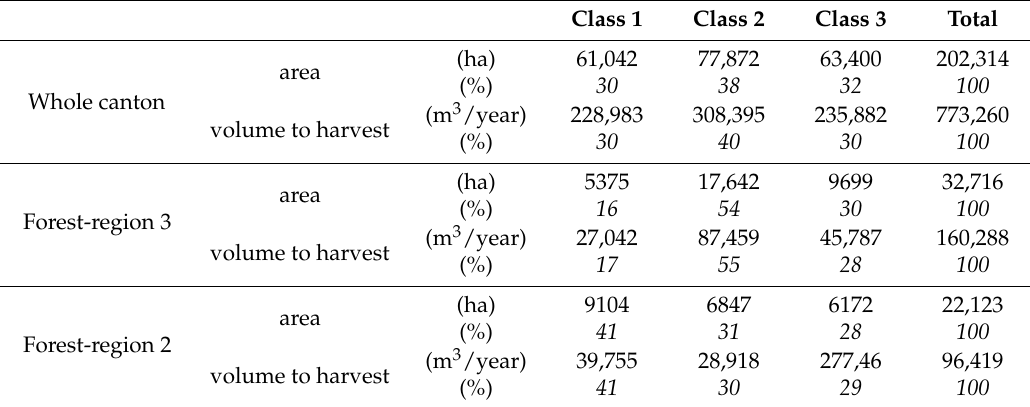
Table 5. Key figures used to determine the suitability of the timber parcels for economical timber production for the entire canton of Grisons and for Regions 2 and 3. (Class 1: Fulfills best practice requirements, Class 2: limited suitability for efficient management, and Class 3: no efficient management